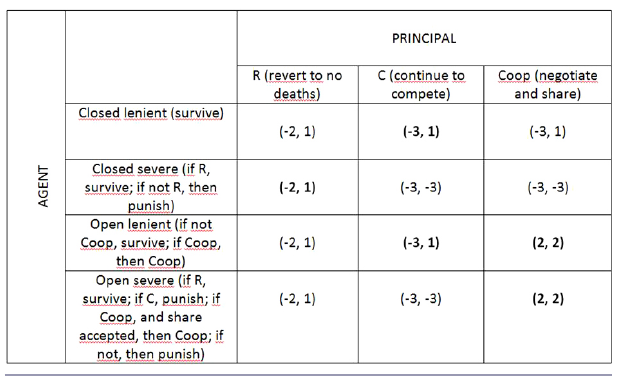
Fig. 7 . Payoff matrix of highest net bonuses attained by a principal and associated agent payoffs. Pairs in bold are the Nash equilibria that actually emerged empirically in the experiment. Note that all equilibria of the dismal game v. 1 and v. 2 were observed experimentally. Pairs in light gray are nonequilibria strategic combinations, common to versions 1 and 2 of the dismal game; they were not